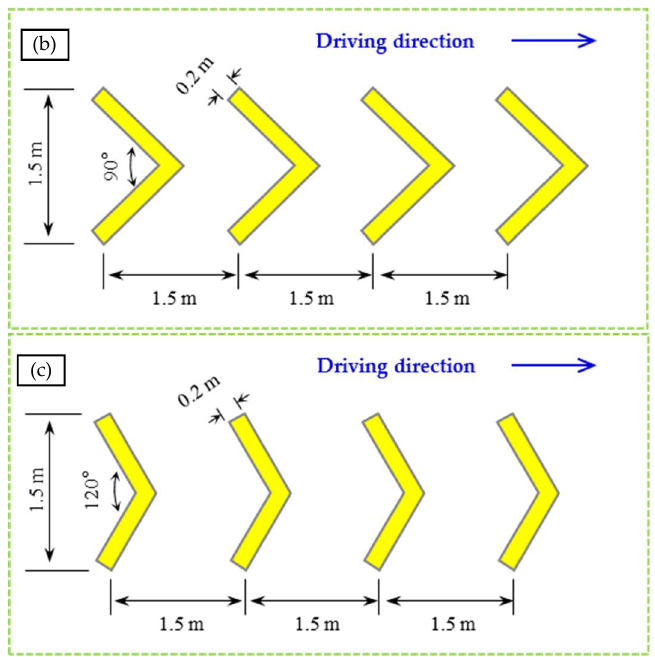
Figure 4. Schematics of fold-line VIDD: ( a ) 60°; ( b ) 90°; ( c ) 120°.